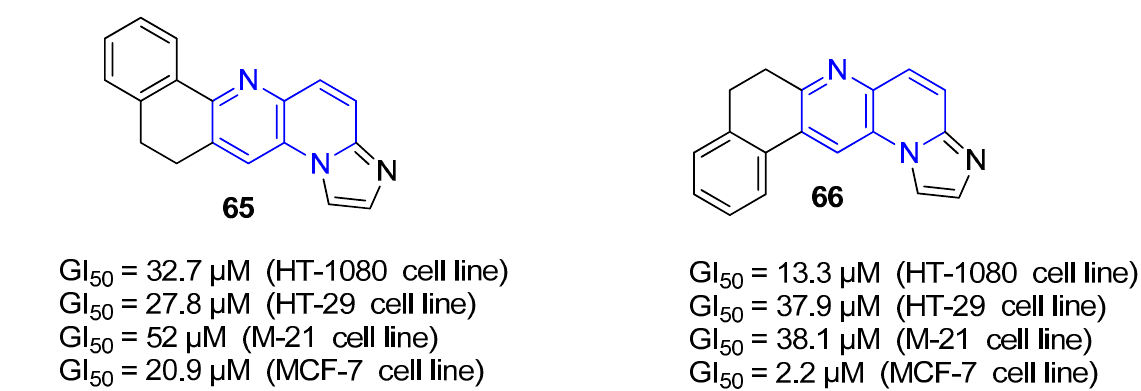
Figure 15. Cytotoxic activity of 65 and 66 on HT-1080, HT-29, M-21, and MCF-7 cell lines.